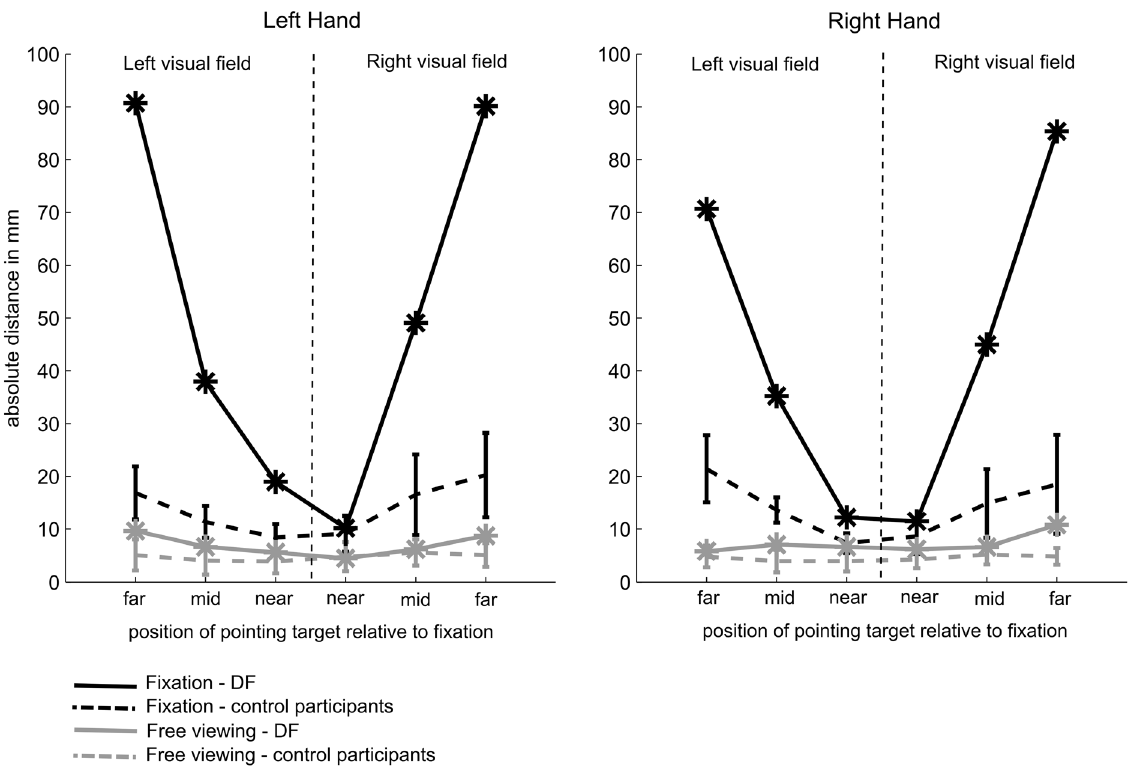
Figure 2. Average 2D-pointing-distance from the target centre as a function of target eccentricity and visual field. Pointing errors are depicted separately for pointing movements performed with the left hand (left panel) and movements performed with the right hand (right panel). Grey lines represent movements executed in the free-viewing conditions and black lines represent movements executed in the fixation conditions. The performance of the controls is represented as dashed lines and DF’s performance as solid lines. Error bars depict the sample standard deviation.